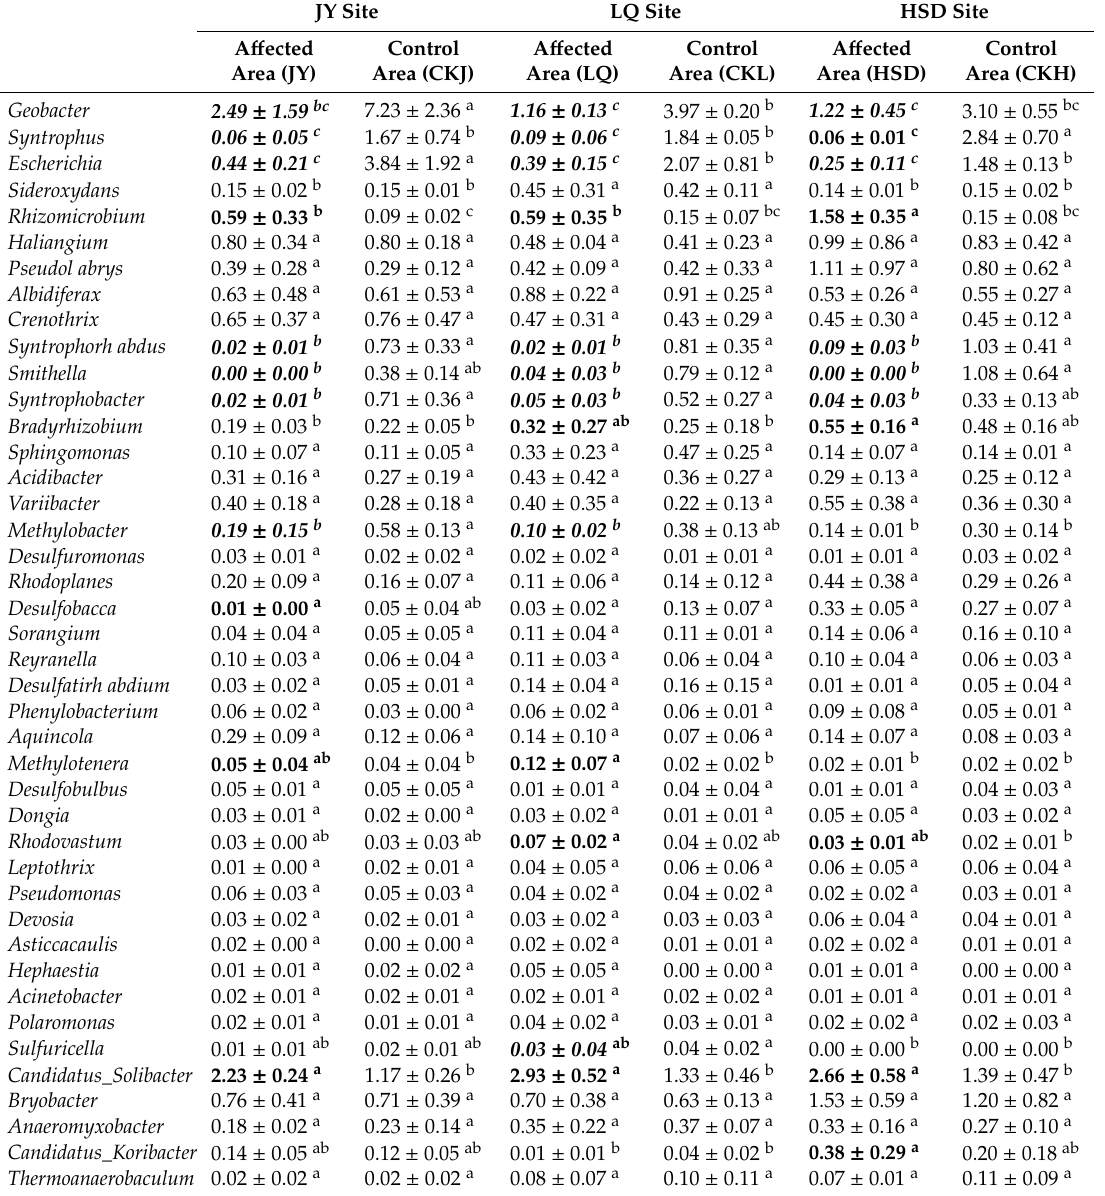
Table 4. Relative abundance of genus (%) for sequence reads in the three sites. (mean ± standard